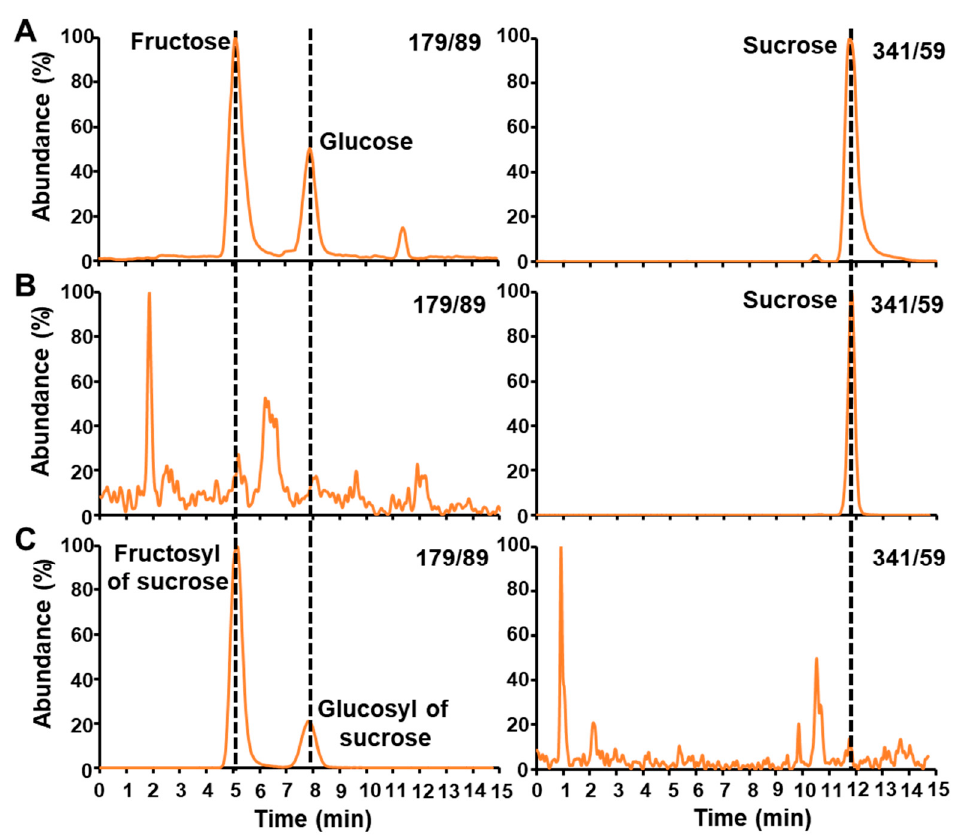
Figure 2. LC-MS / MS chromatograms of free sugars before and after enzymatic treatments. ( A ) shows the chromatographic separation and mass spectrometric detection of fructose, glucose (transition 179 / 89), and sucrose (transition 341 / 59) after boiling water extraction of unlabeled maize embryos. ( B ) and ( C ) represent the LC-MS / MS chromatograms obtained after hexokinase and invertase treatments, respectively. LC-MS / MS chromatograms for hexoses and sucrose were obtained using MRM scan survey approach as indicated in the Materials and Methods.